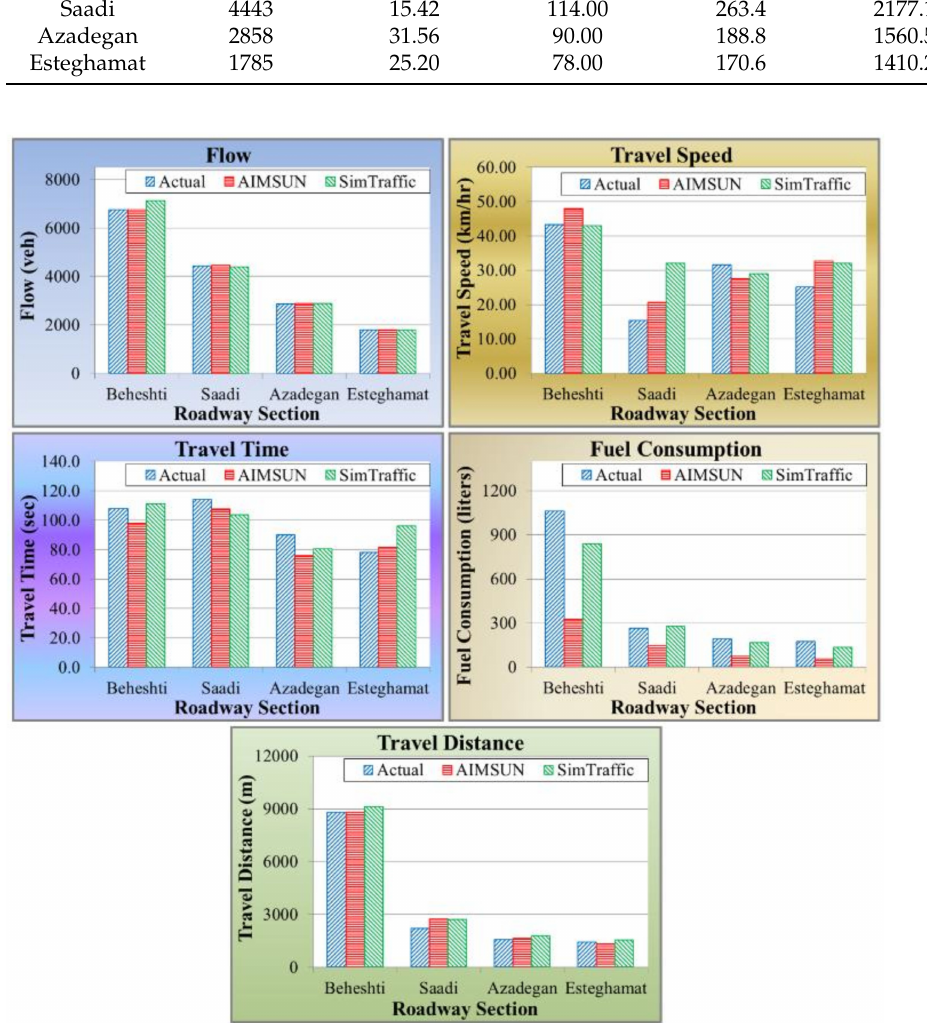
Figure 3. Transportation network performance indicators: actual vs. AIMSUN vs.